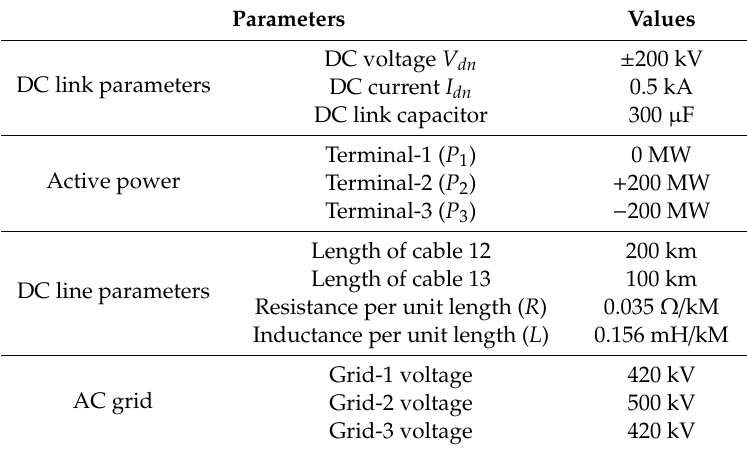
Table A1. Three-terminal VSC-HVDC parameters.